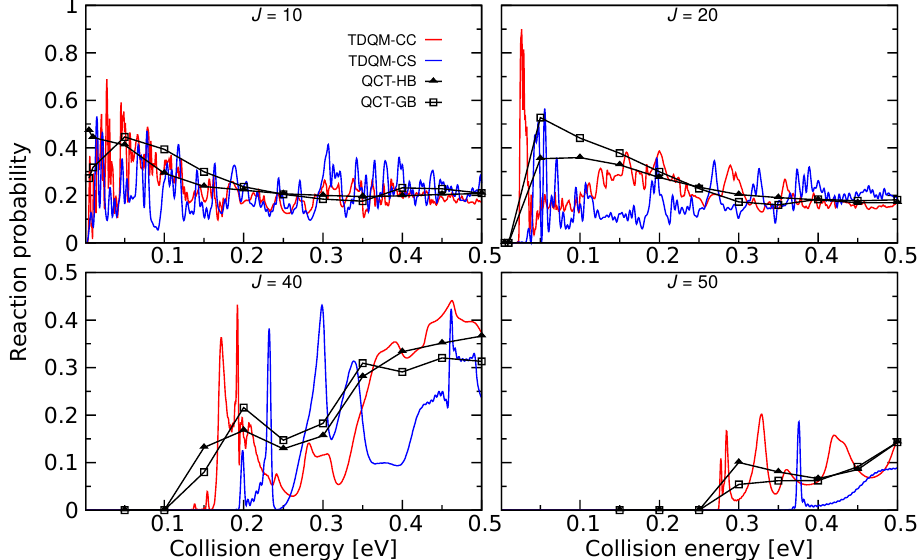
Figure 4. Total reaction probabilities as a function of collision energies for the He + HeH + ( v = 0, j = 0 ) → HeH + + He for J = 10, 20, 40 and 50 computed by means TDQM-CC (red solid lines), TDQM-CS (blue solid lines), and QCT (QCT-HB: black lines + filled triangles, QCT-GB: black lines+open squares) methods. TDQM-CS data are taken from Ref. [36].